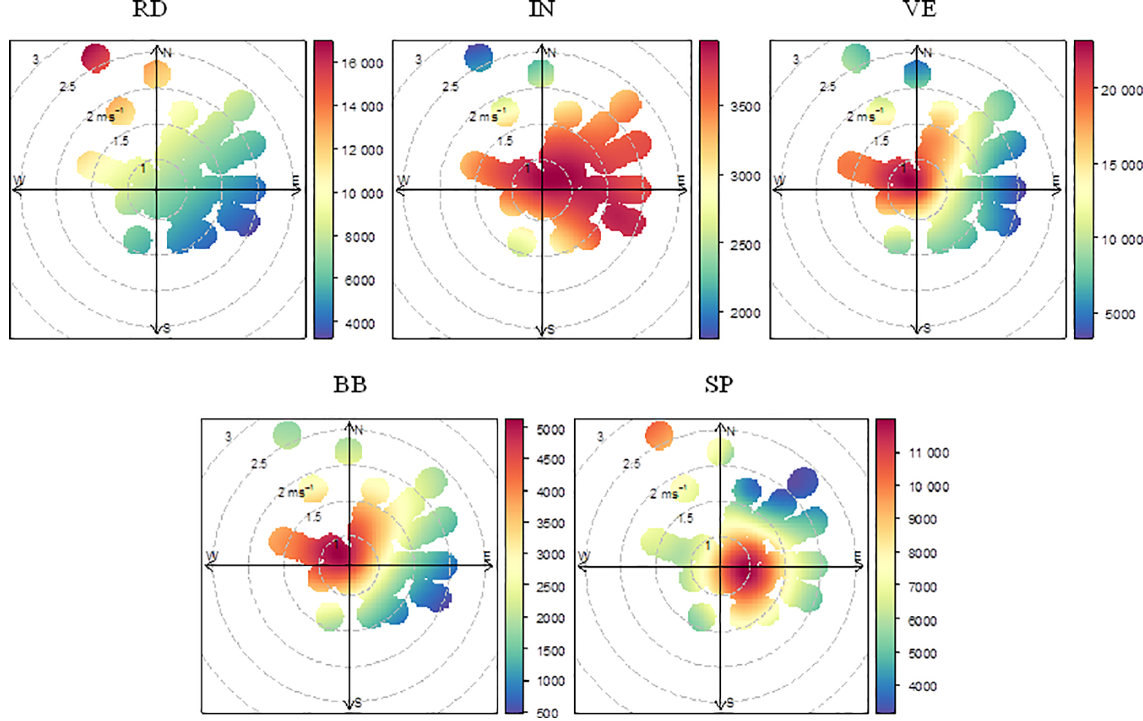
Figure 10. Polar plots of source contributions in São Paulo (ngm − 3 and ms − 1 )